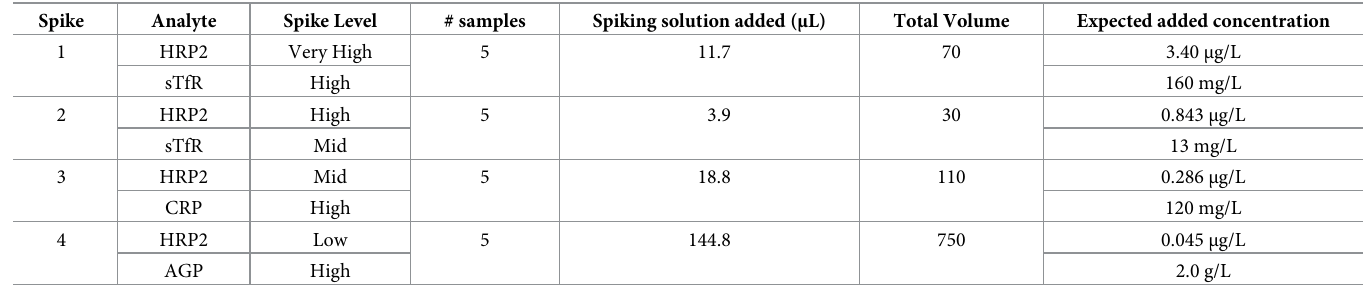
Table 1. Contrived blood samples spiked with a range of elevated levels of AGP, CRP, HRP2 and sTfR. Spike Analyte